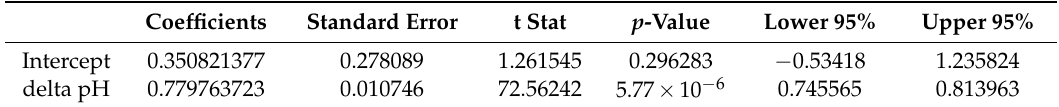
Table 4. Regression Statistics.